Question: Is the quantity shown trending increasing or decreasing?
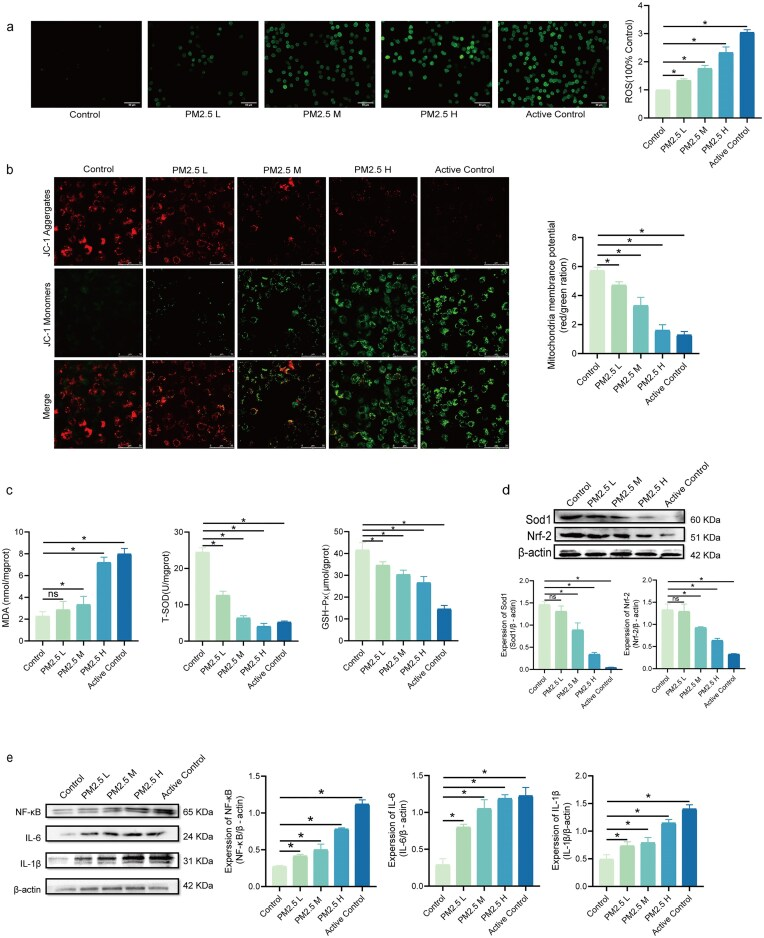
Answer: increasing